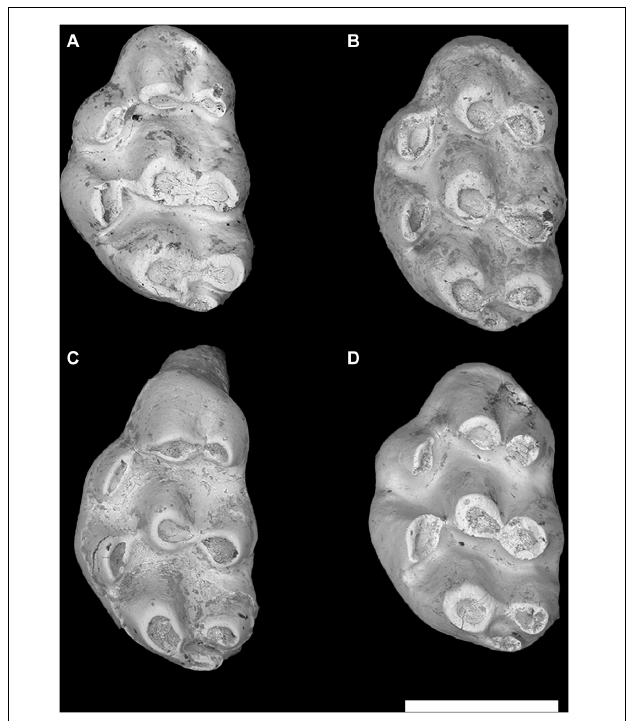
FIGURE 7 | Four left M1 from locality Y76, 11.4 Ma, showing stem murinin-arvicanthin morphology. (A) YGSP 33586, (B) 33571, (C) 33591, and (D) 33572. Of these four, panel (C) is Progonomys -like; the others resemble Karnimata . Same 1 mm scale, anterior